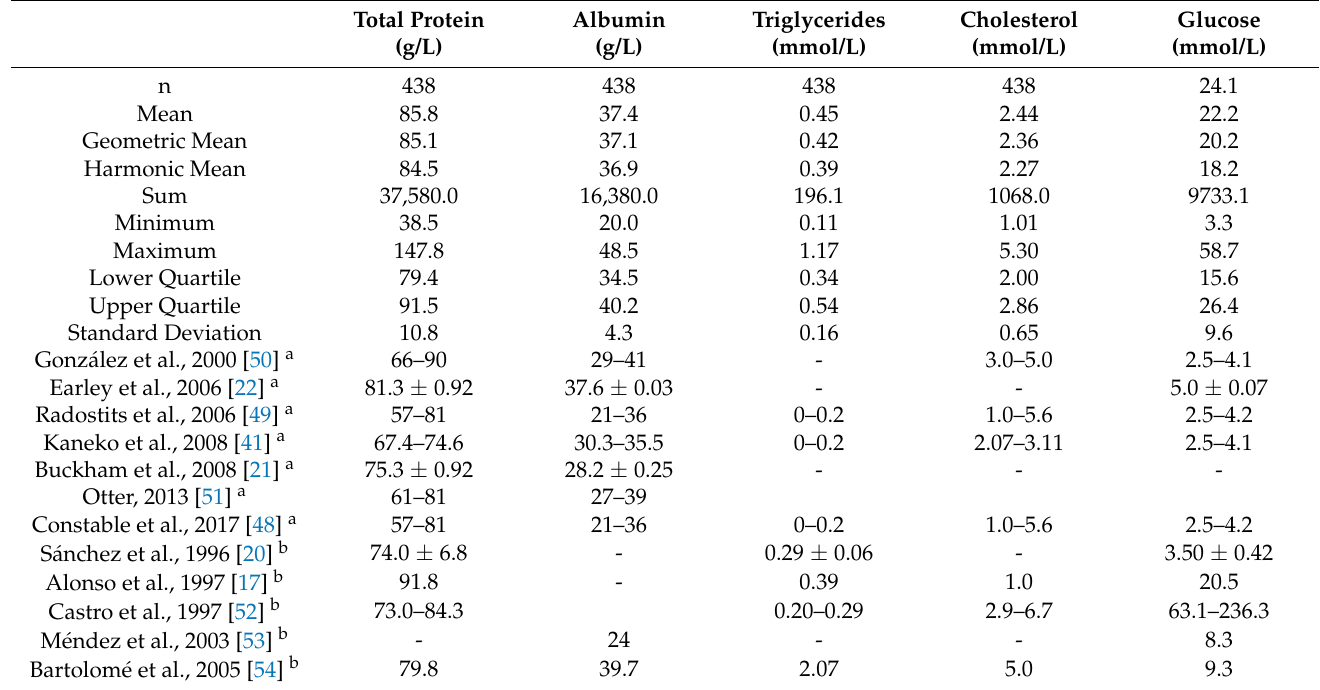
Table 1. The plasma concentrations of uric acid, creatinine, urea, cortisol, and testosterone are listed in Table 2. Plasma glucose concentrations are represented in Figure 1. Finally, the plasma concentrations obtained from the enzymatic and hormonal profile are listed in Tables 2 and 3. Table 1. Summary statistics of biochemical variables (I) in Lidia bulls’ plasma. Values found by other authors are also shown, both in Lidia breed and in other breeds.